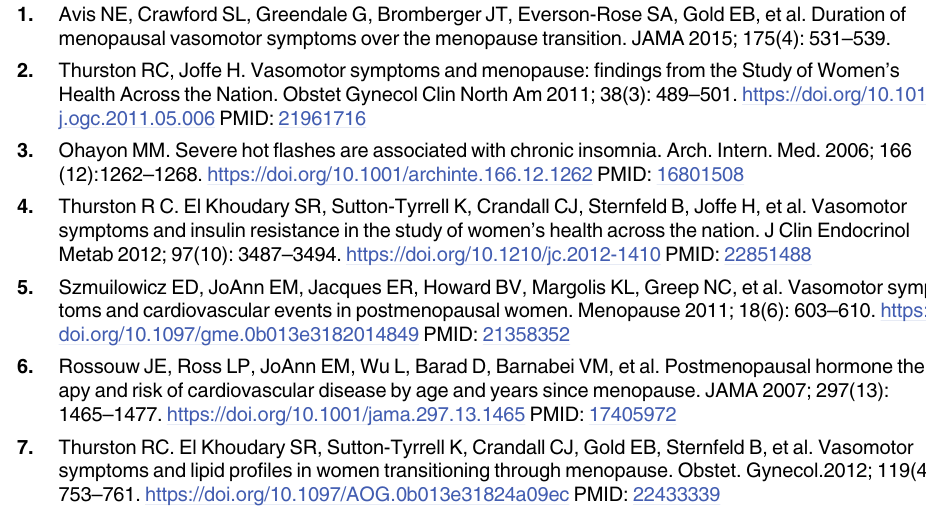
S1 Table. Association of HOMA-IR index with hot flash status and adipocyte-derived hor- mones without adjustment for hot flash status, follicle stimulating hormone, body mass index, age, and menopause